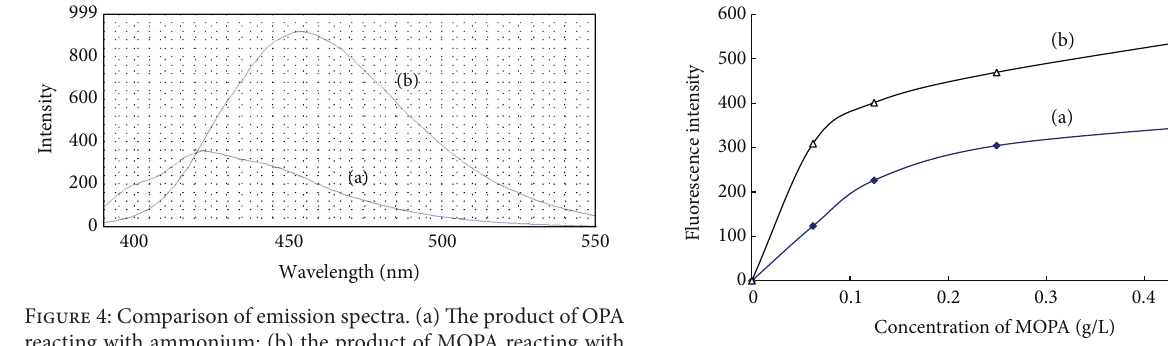
Figure 6: Effect of MOPA concentration on the fluorescence inten- sities of blank (a) and 0.200 𝜇 mol/L ammonium working solution